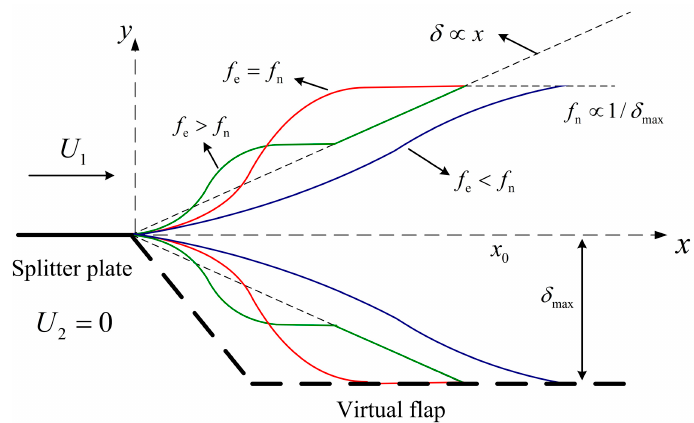
Figure 9. Entrainment ratio of free shear layer (referring to [1]): ( a ) Diagram of entrainment ratio; ( b ) curve of entrainment ratio.